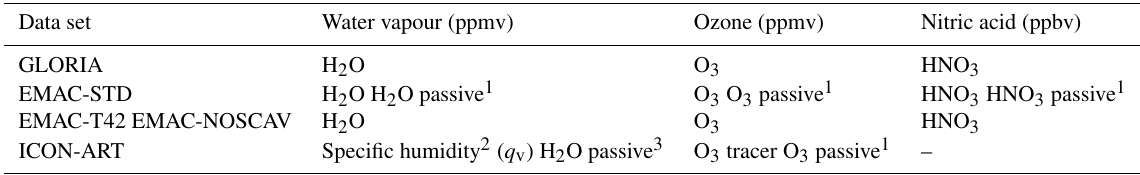
Table 2. Data sets, trace gas products and sensitivity simulations. Data